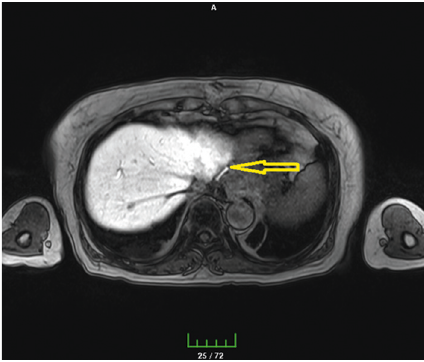
Figure 2: MRCP imaging. Bile leakage is shown in the drain.